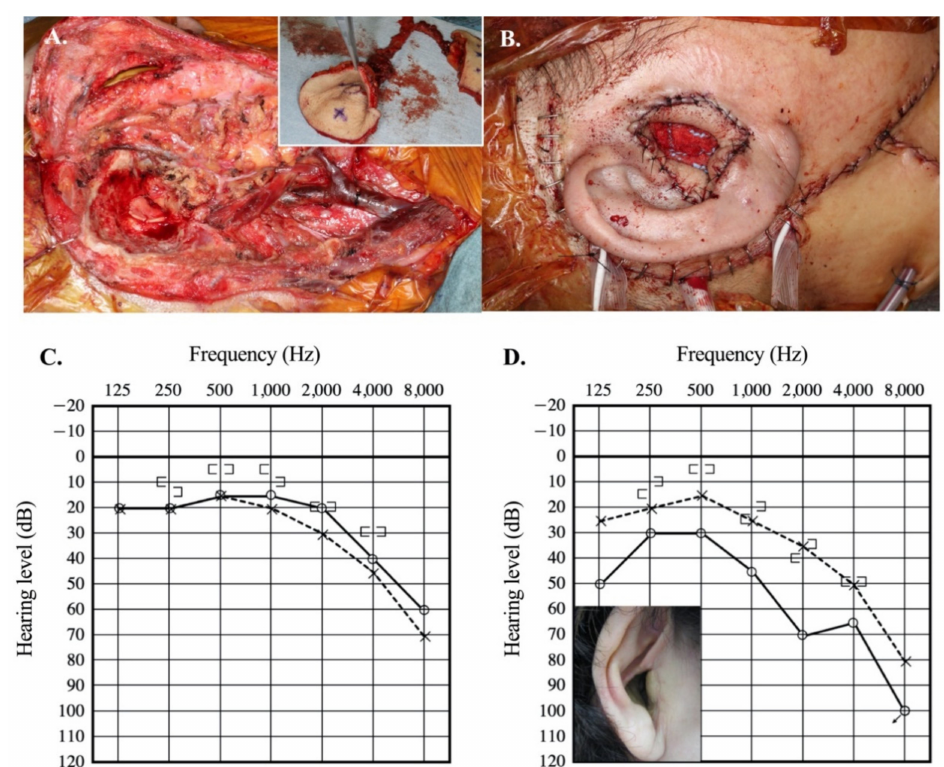
Figure 1. Reconstruction of the external auditory canal after lateral temporal bone resection. ( A ) Surgical view of completed lateral temporal bone resection. An inset shows the harvested free anterolateral thigh flap, which is rolled to create the external auditory meatus. ( B ) Final view after reconstruction of the external auditory meatus. ( C ) Preoperative pure-tone audiometry (Case 1) ( D ) Postoperative pure-tone audiometry one year after surgery (Case 1). Inset shows the reconstructed auditory canal in Case